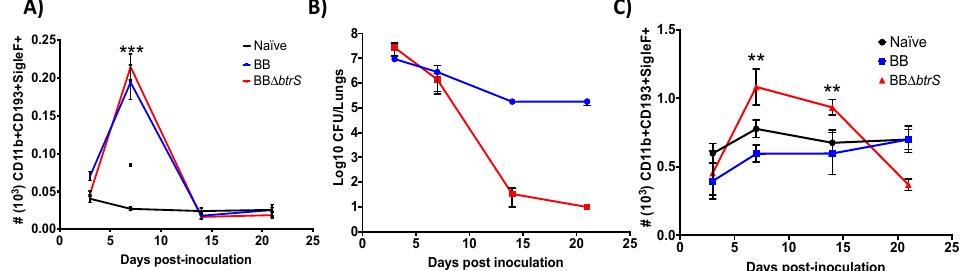
Figure 1. Eosinophils numbers increase in the spleen, but btrS blocks their recruitment to lungs. C57BL/6J mice were intranasally inoculated with PBS (black), or PBS containing 5 × 10 5 CFU of Bb (blue) or Bb Δ btrS (red). Mice were euthanized at different times, to enumerate CFU ( B ) and eosinophils CD11b + CD193 + SiglecF + in the spleen ( A ) and the lungs, CD11b + CD193 + SiglecF + ( C ). The graphs show the average and SEM. ** p < 0.001 and *** p < 0.0001, using two-way ANOVA test N = 10.